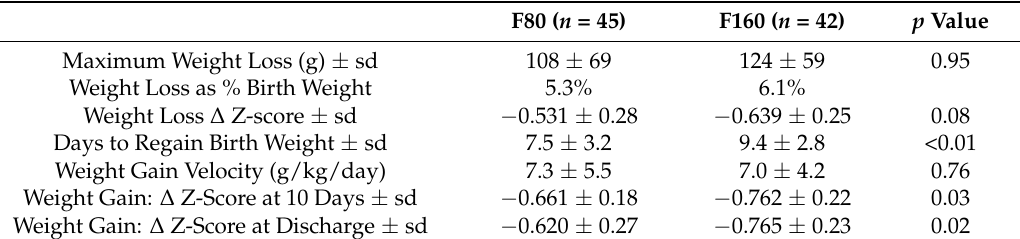
Table 2. Anthropometric findings.